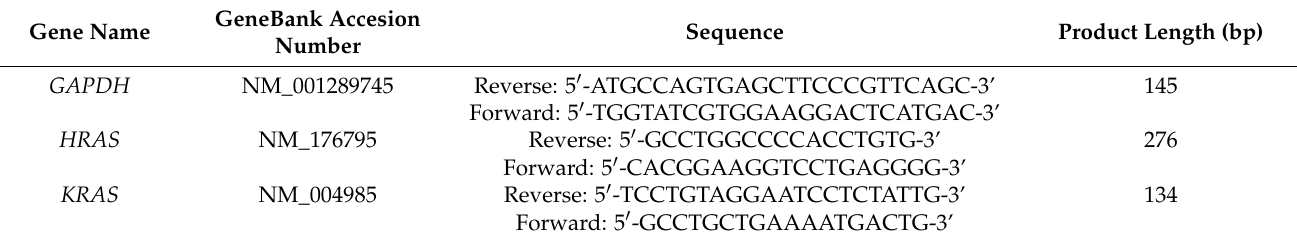
Table 1. Sequences of primers used in the